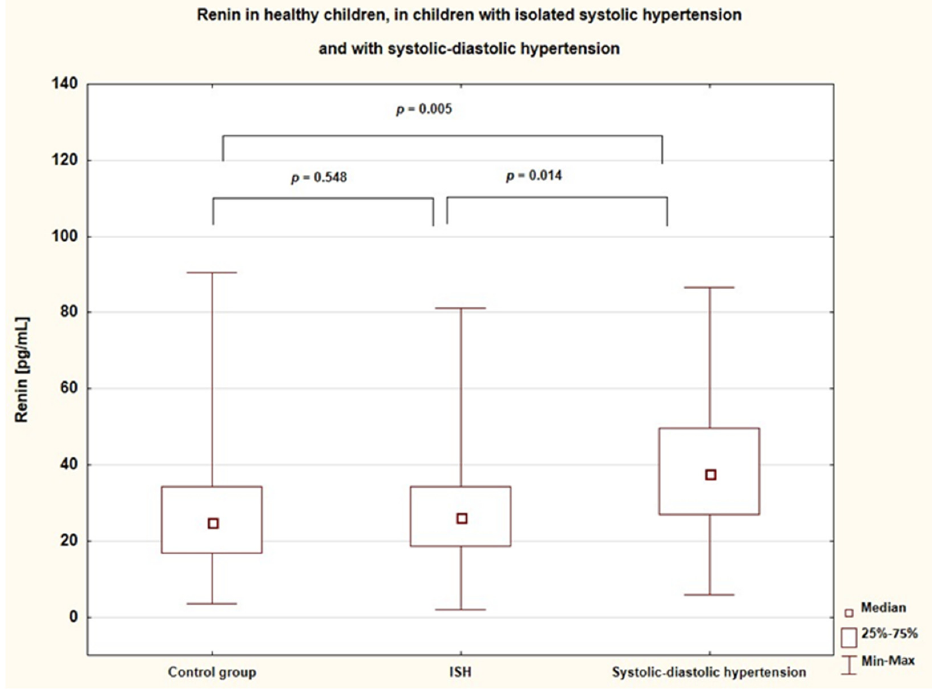
Figure 1. Active renin concentration in healthy children, in children with isolated systolic hypertension, and with systolic-diastolic hypertension (ISH—isolated systolic hypertension).